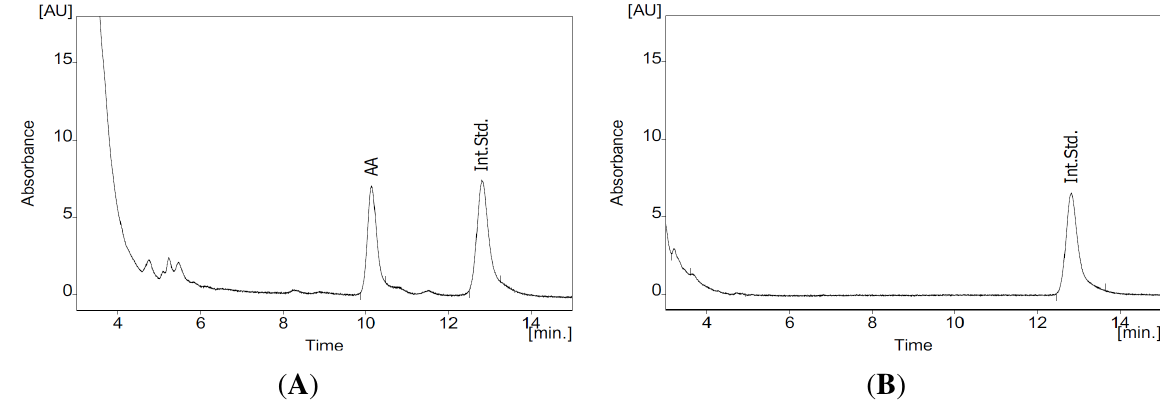
Figure 1. HPLC chromatogram of a sample of Ononis spinosa herb extract (100 µg/mL) α . Absorbance (AU, y-axis) is depicted in relation to time (min, x-axis) incubated with cPLA 2 at a detection wavelength of 200 nm ( A ) and 254 nm ( B ), respectively. AA = arachidonic acid peak; Int.Std. = the peak of the internal standard 4-undecyloxybenzoic